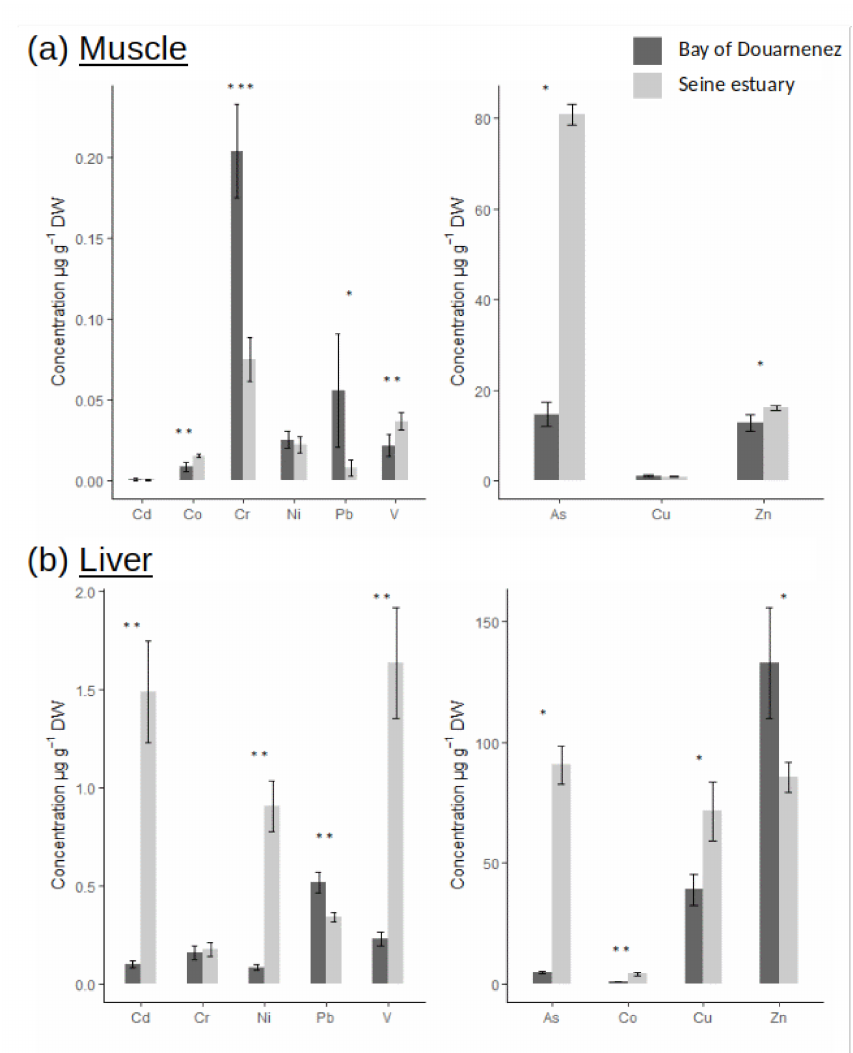
Figure 2. Metal concentrations ( µ g.g − 1 DW) in muscle ( a ) and liver ( b ), for two fish populations (Seine and Douarnenez). ( p -value following Kruskal-Wallis test: *: p -value < 0.05; **: p -value < 0.01; ***: p -value <